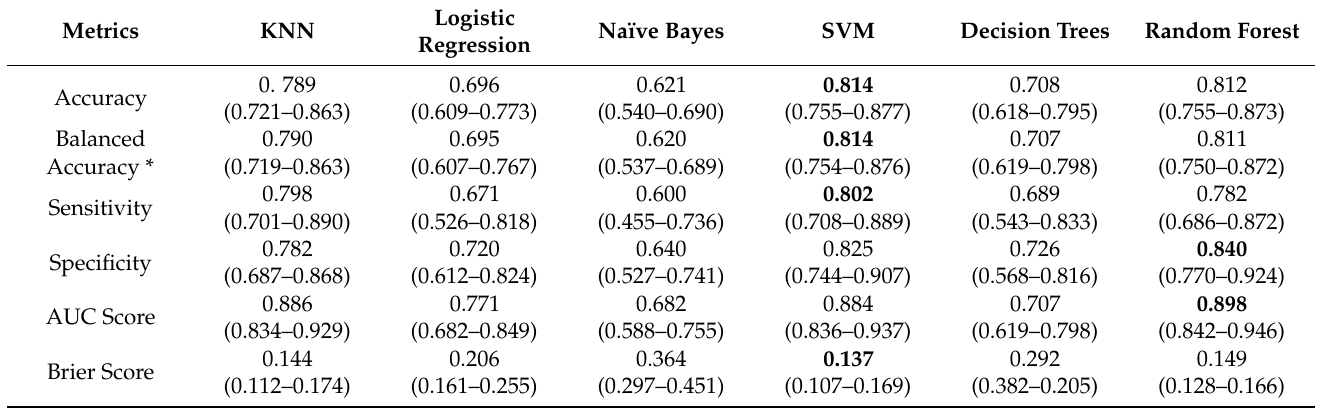
Table 3. Summary of the cross-validation during training of the classification machine